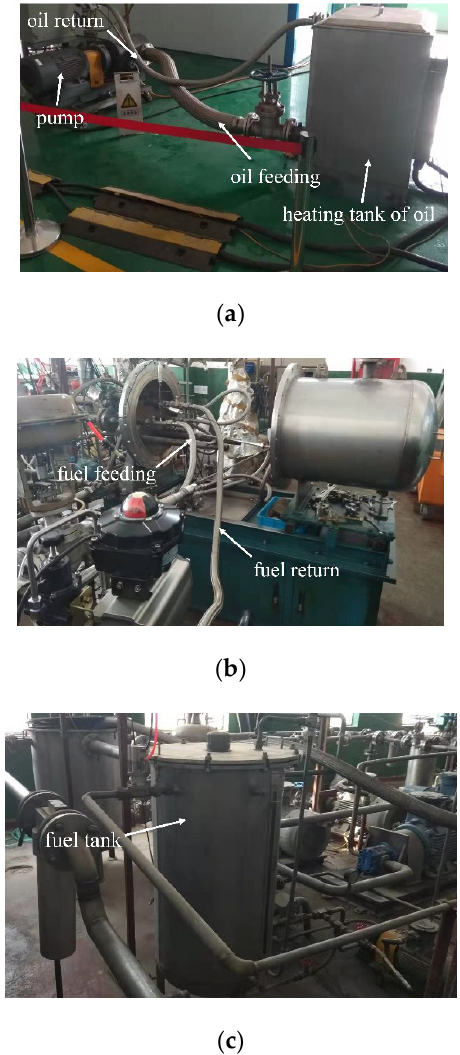
Figure 4. Testing equipment: ( a ) testing equipment of the oil side; ( b ) one part of testing equipment of the fuel side; ( c ) the other part of testing equipment of the fuel